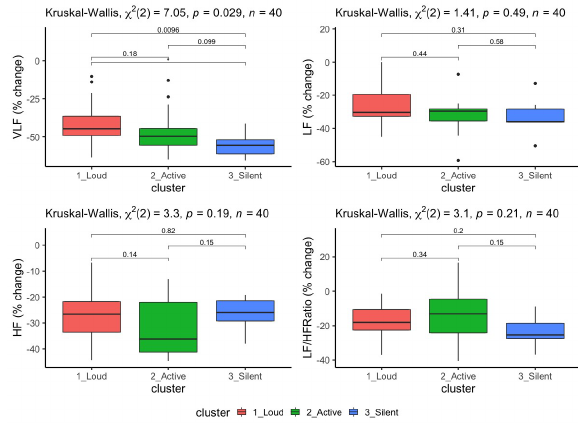
Figure 7: Relative Change (%) in frequency domain HRV parameters for different soundscape